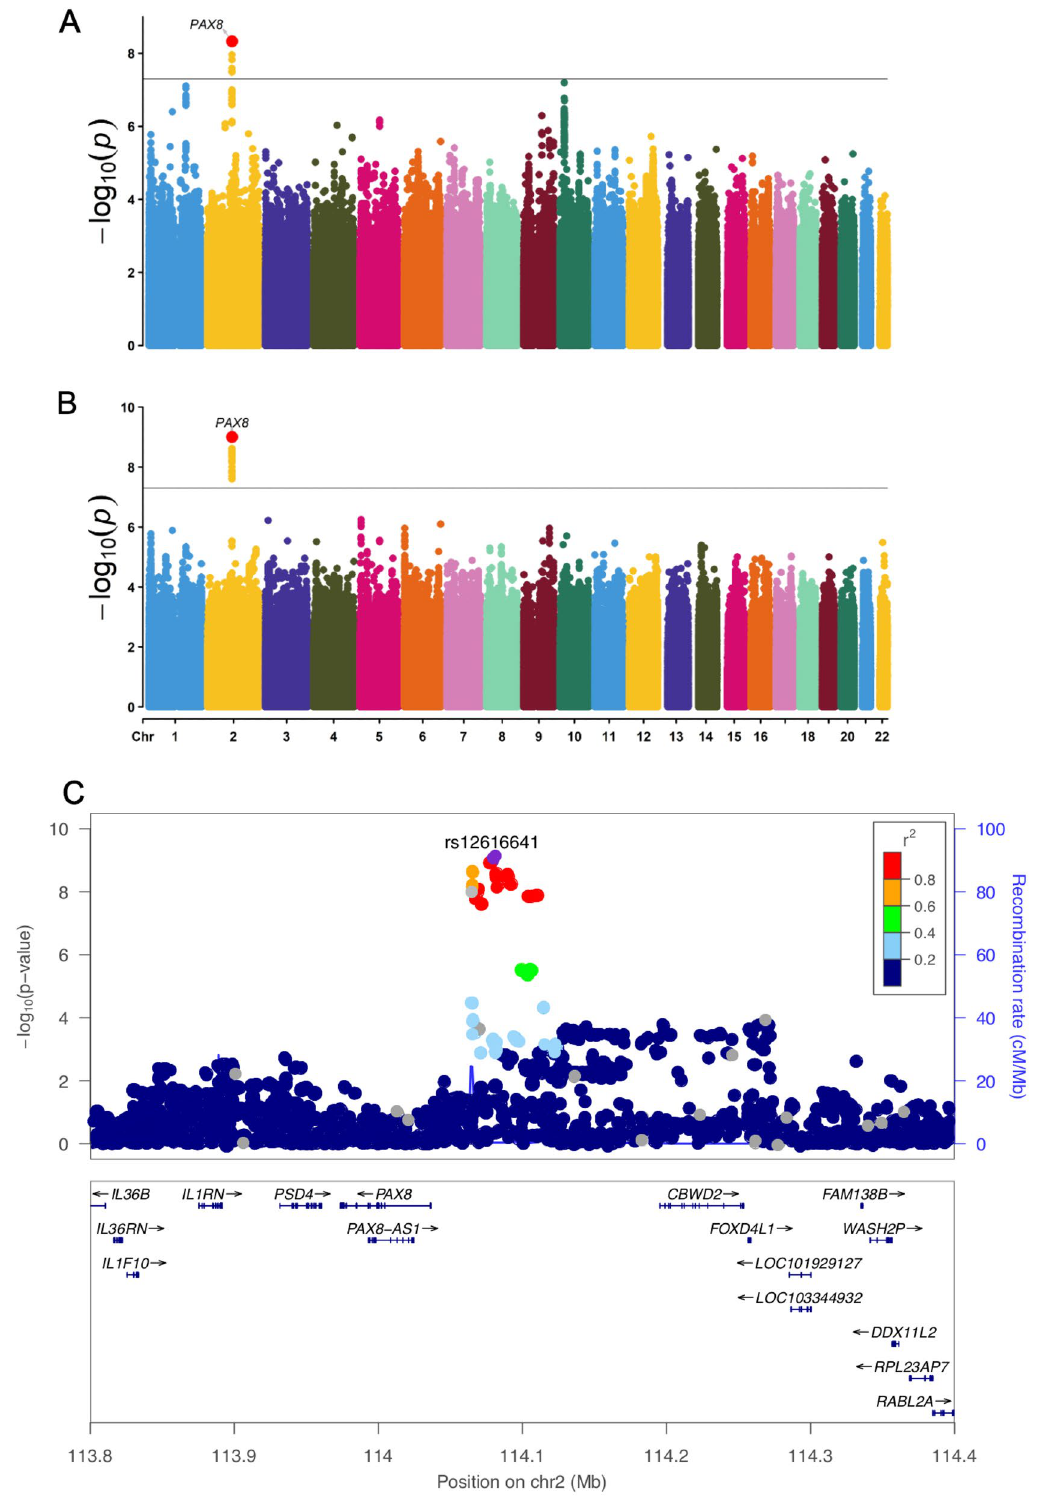
Figure 3. GWAS Manhattan Plots for strength of limbic and somatomotor networks and the locus zoom plot for the identified chromosome 2 region. ( A ) represents the Manhattan plot for strength of limbic network; ( B ) represents the Manhattan plot for strength of somatomotor network. For each of the Manhattan plots, each point represents a single genetic variant plotted according to its genomic position (x-axis) and its association with the relevant graph theory measure is shown by the corresponding –log 10 (P) values on the y-axis. Linear regression models were adjusted for age, age 2 , sex, age × sex, age 2 × sex, head motion from resting-state fMRI, head position, volumetric scaling factor needed to normalize for head size, genotyping array and 10 genetic principal components. The black solid line represents the classical GWAS significance threshold of p < 5 × 10 –8 . ( C ) The Locus zoom plot showing the chromosome 2 locus significantly associated with both the strength of somatomotor and limbic networks. Rs12616641 is the lead